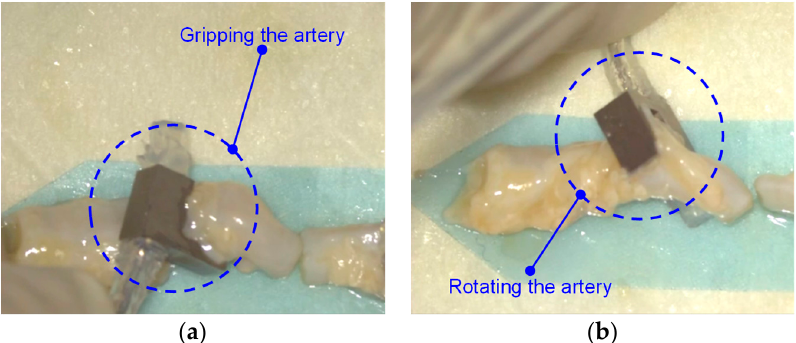
Figure 13. Gripping experiment on an artery using the soft hybrid surgical gripper (the figures were captured from microscopic view): ( a ) gripping the artery using the inflated balloon; ( b ) rotating the artery for observation.